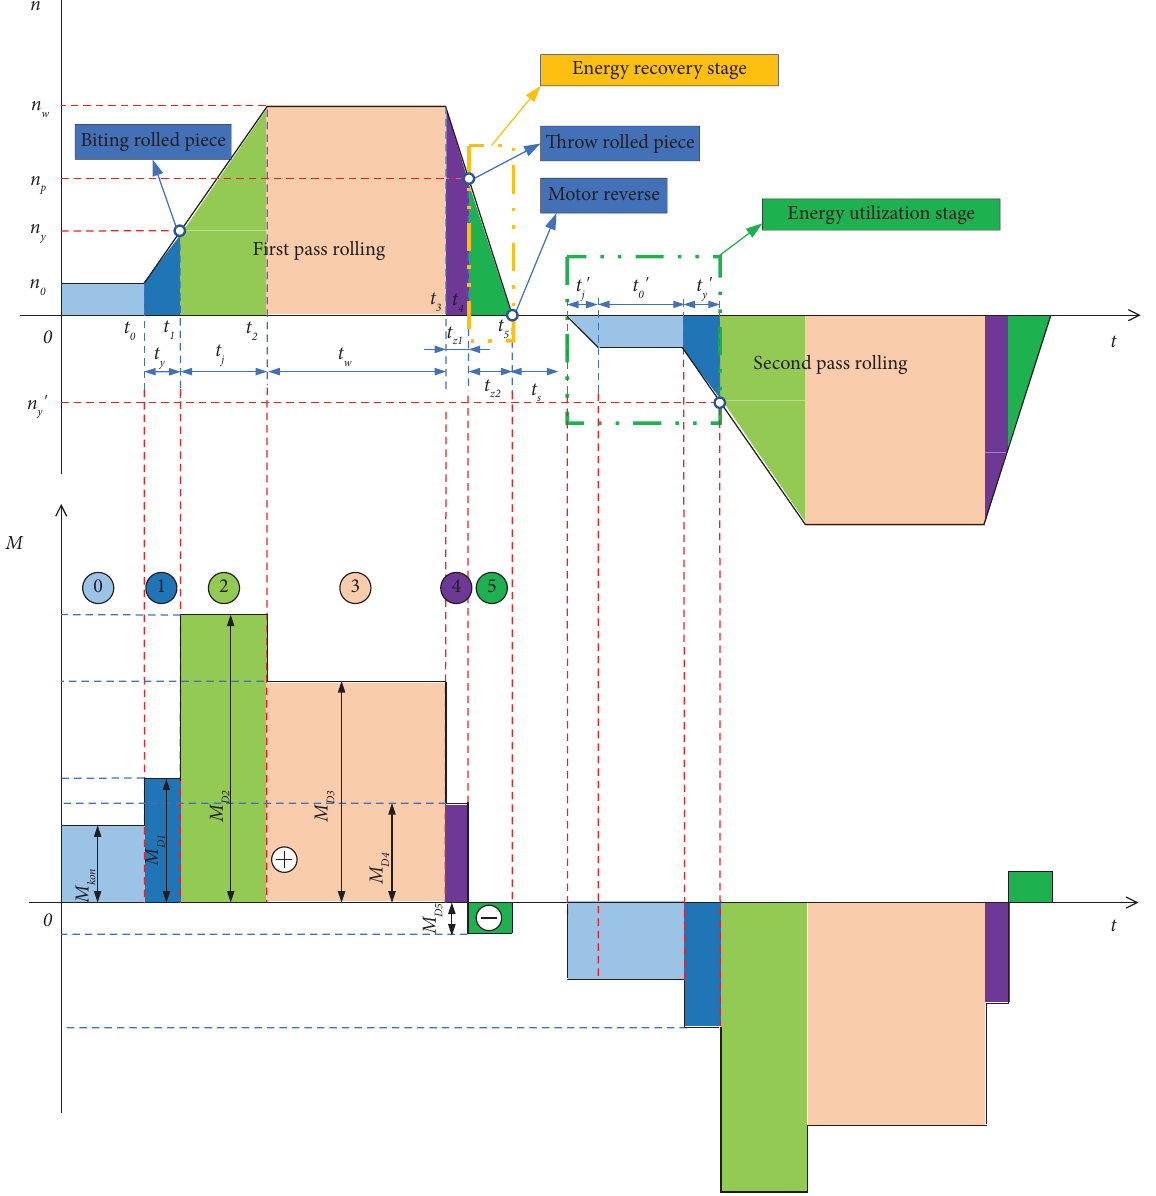
Figure 3: Rolling speed diagram and load diagram of the reversible rolling mill. Table 2: Description of speed and torque of one pass of the reversible rolling